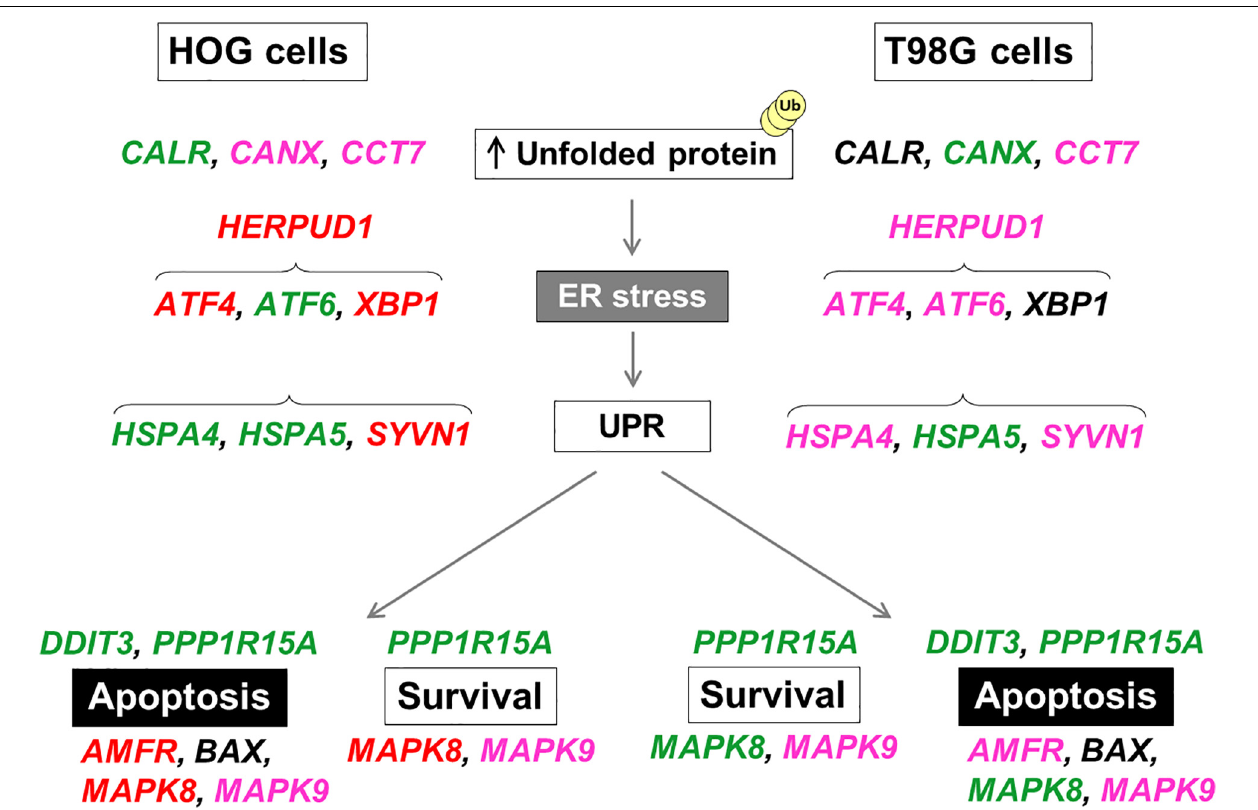
FIGURE 7 | Schematic representation of upregulated UPR-related genes in HOG and T98G cells by DHE or BRA-346 epoxyketone-containing fraction. Each gene selected for validation acts on the unfolded protein response (UPR) and endoplasmic reticulum stress (ER-stress) and shows different regulation in HOG and T98G cells for each treatment. Treatments were performed with DHE at 40 ng/mL (both cell lines) and BRA-346 epoxyketone-containing fraction at 17.6 and 28.2 ng/mL for HOG and T98G, respectively. Genes in green were found to be upregulated following exposure to both DHE and BRA-346 epoxyketone-containing fraction; genes in red were upregulated only by BRA-346 epoxyketone-containing fraction; genes in pink were upregulated only by DHE; and genes in black were not upregulated. Data of relative expression were obtained from average values for each gene normalized by the average values for reference genes by the 2 − (cid:49)(cid:49) CT method from three experiments ( Supplementary Table 5